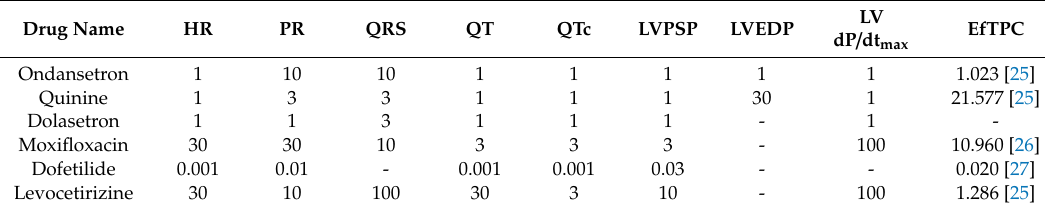
Figure 4. Comparison between drugs with cardiovascular e ff ects and chlorogenic acid (CGA) in the parameters of the Langendor ff perfused heart assay. Each error bar represents mean ± SD (n = 3). (cid:7) : depicts e ff ective free therapeutic plasma concentration (color corresponds to each drug). CGA’s e ff ect on each parameter was weaker than that of the drugs. Table 1. Lowest concentration indicating statistically significant % change to solvent control for assessed parameters and e ff ective free therapeutic plasma concentrations (EfTPC) of each drug ( µ